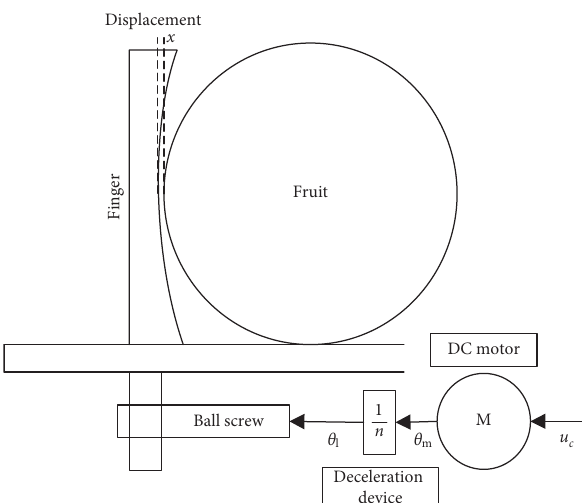
Figure 6: Driving mechanism and the end-effector